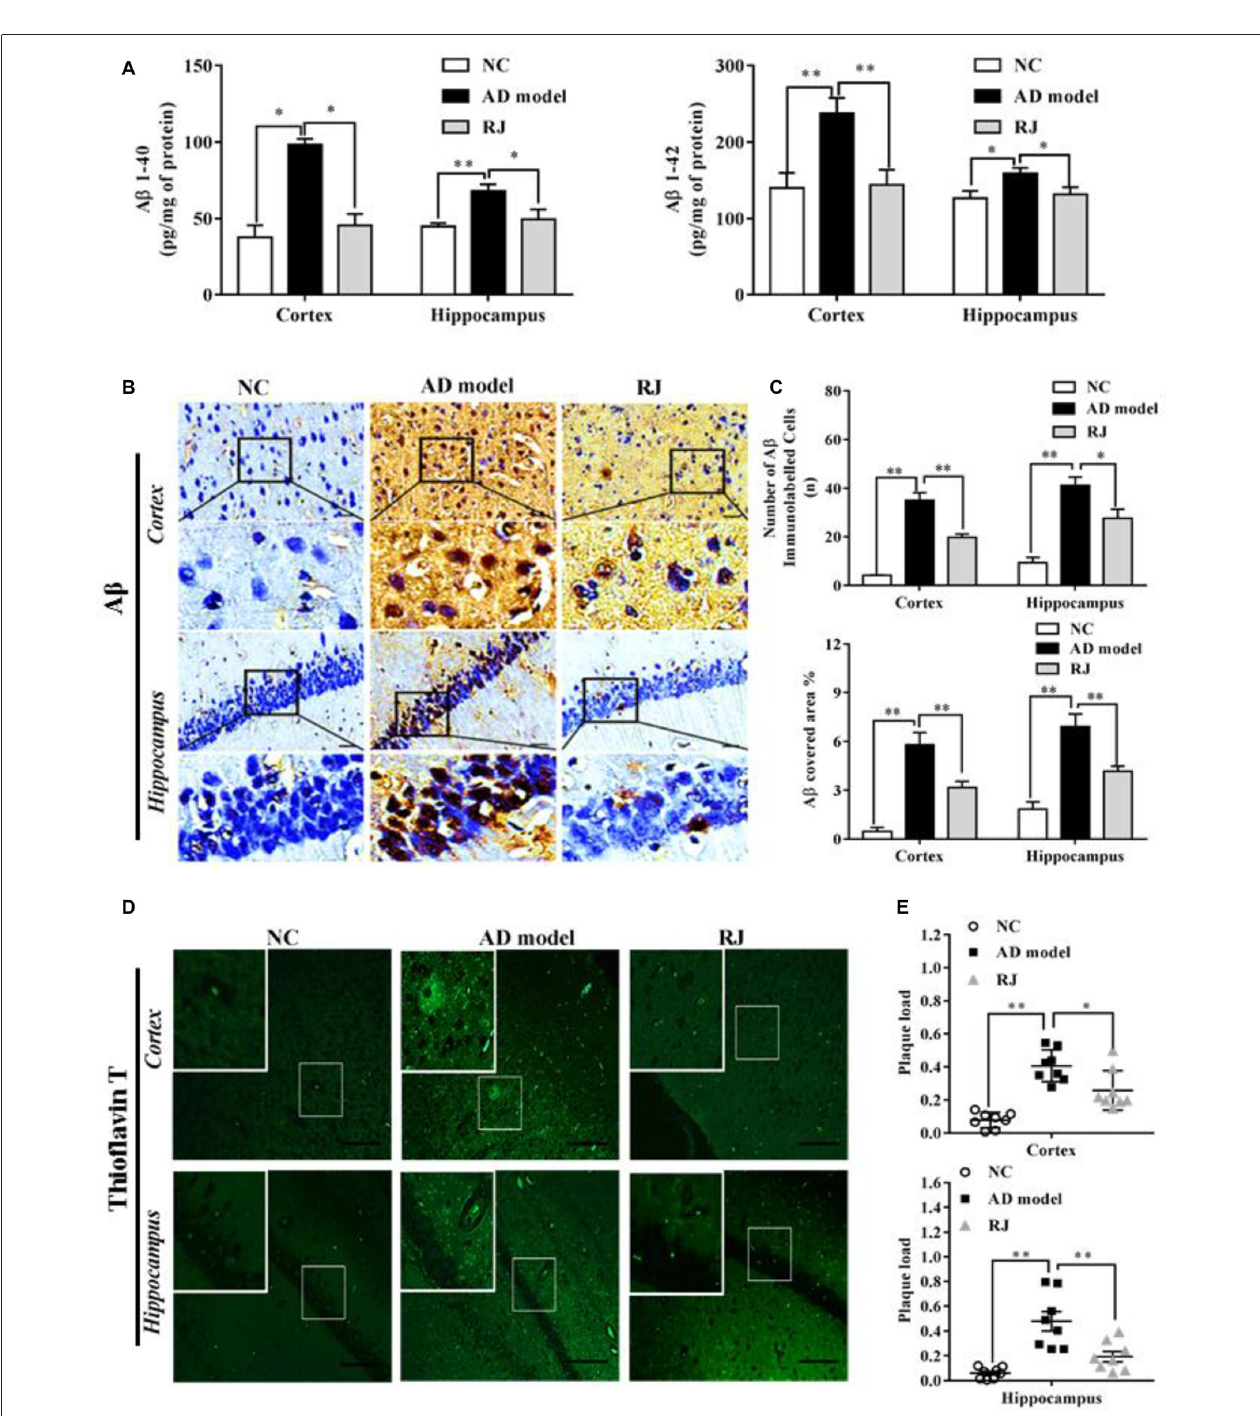
FIGURE 2 | Royal jelly (RJ) decreased brain amyloid β (A β ) levels and alleviated A β pathology in Alzheimer’s disease (AD) rabbits. (A) The levels of A β 1–40 and A β 1–42 in the cortex and the hippocampus of each group measured by ELISA, n = 6 rabbits per group. (B) Representative A β -staining images in the cortex and the hippocampus of each group. Scale bar = 50 µ m. Black squares indicate images with higher-magnification. A β positive (brown-colored) was detected mainly in the cytoplasm of neuronal cells and the cytoplasm and membranes of endothelia cells. (C) The number of A β immunolabeled cells per view (40 × ) and the covered area of A β staining in the brain of each group, n = 6–8 rabbits per group. (D) An example image of A β plaque immunoreactivity in the cortex and the hippocampus of each group by thioflavin-T staining. Scale bar = 50 µ m. White squares indicate images with higher-magnification. (E) Quantification of thioflavin-T positive deposits in the cortex and the hippocampus of the three groups, n = 8 rabbits per group. Data are presented as mean ± SEM. ANOVA with post hoc Tukey’s test was used (A,C,E) . ∗ P < 0.05, ∗∗ P < 0.01 vs. the AD model group.